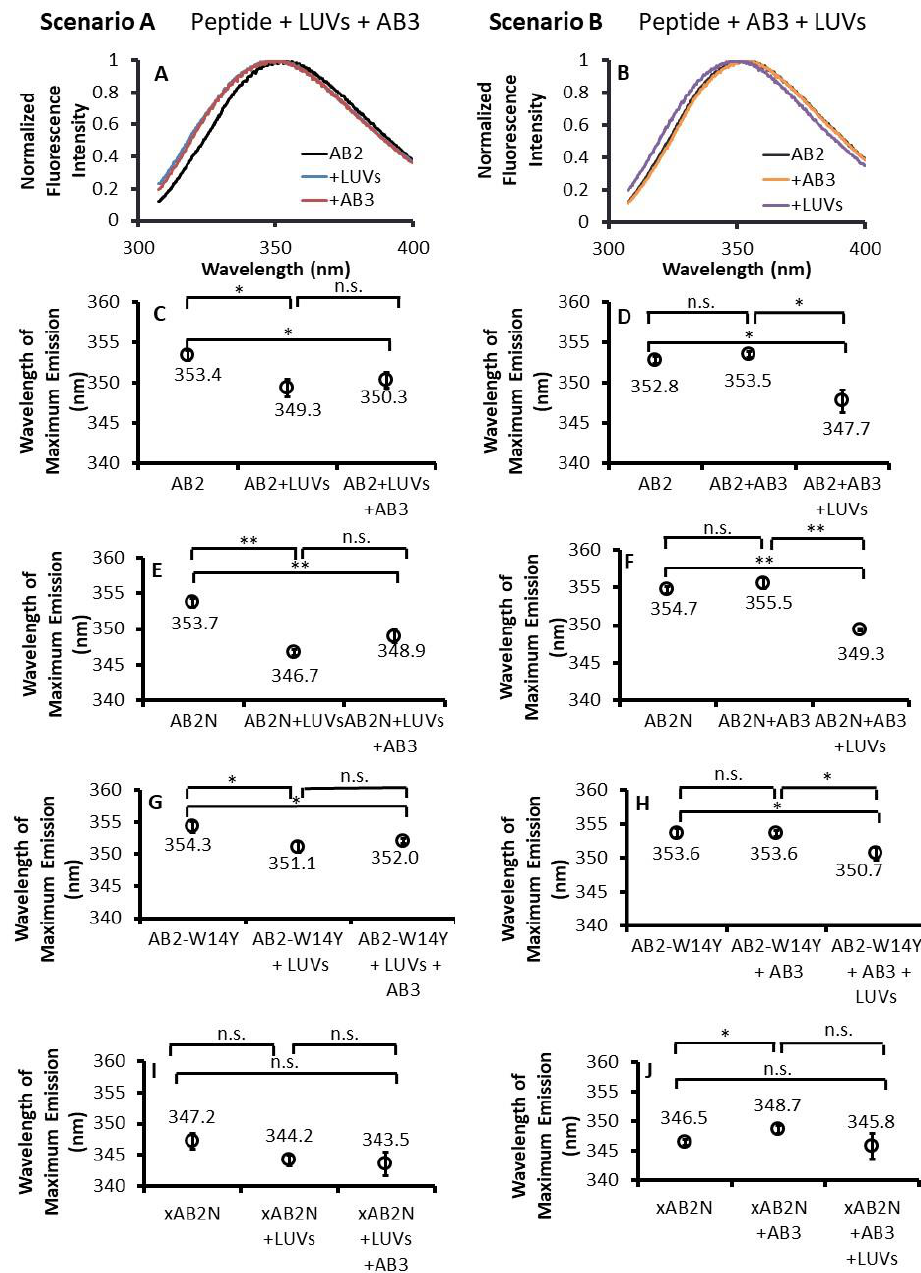
Figure 6. Intrinsic tryptophan fluorescence on Scenarios A and B depicted in. Representative spectra ( A , B ) and wavelengths of maximum emission ( C , D ) from 8 µ M AB2 with 240 µ M LUVs, then with 40 µ M AB3 subsequently added ( A , C ), and 8 µ M AB2 with 40 µ M AB3, then with 240 µ M LUVs subsequently added ( B , D ). Wavelengths of maximum emission from ( E ) 8 µ M AB2N with 240 µ M LUVs, then with 40 µ M AB3 subsequently added; ( F ) 8 µ M AB2N with 40 µ M AB3, then with 240 µ M LUVs subsequently added; ( G ) 8 µ M AB2-W14Y with 240 µ M LUVs, then with 40 µ M AB3 subsequently added; ( H ) 8 µ M AB2-W14Y with 40 µ M AB3, then with 240 µ M LUVs subsequently added; ( I ) 8 µ M xAB2N with 240 µ M LUVs, then with 40 µ M AB3 subsequently added; and ( J ) 8 µ M xAB2N with 40 µ M AB3, then with 240 µ M LUVs subsequently added. Representative spectra for conditions in ( E – J ) shown in Figure S4. One-tailed Student’s t -test; n = 3; ** p < 0.01; * p < 0.05; n.s., not significant. Error bars represent standard errors of the